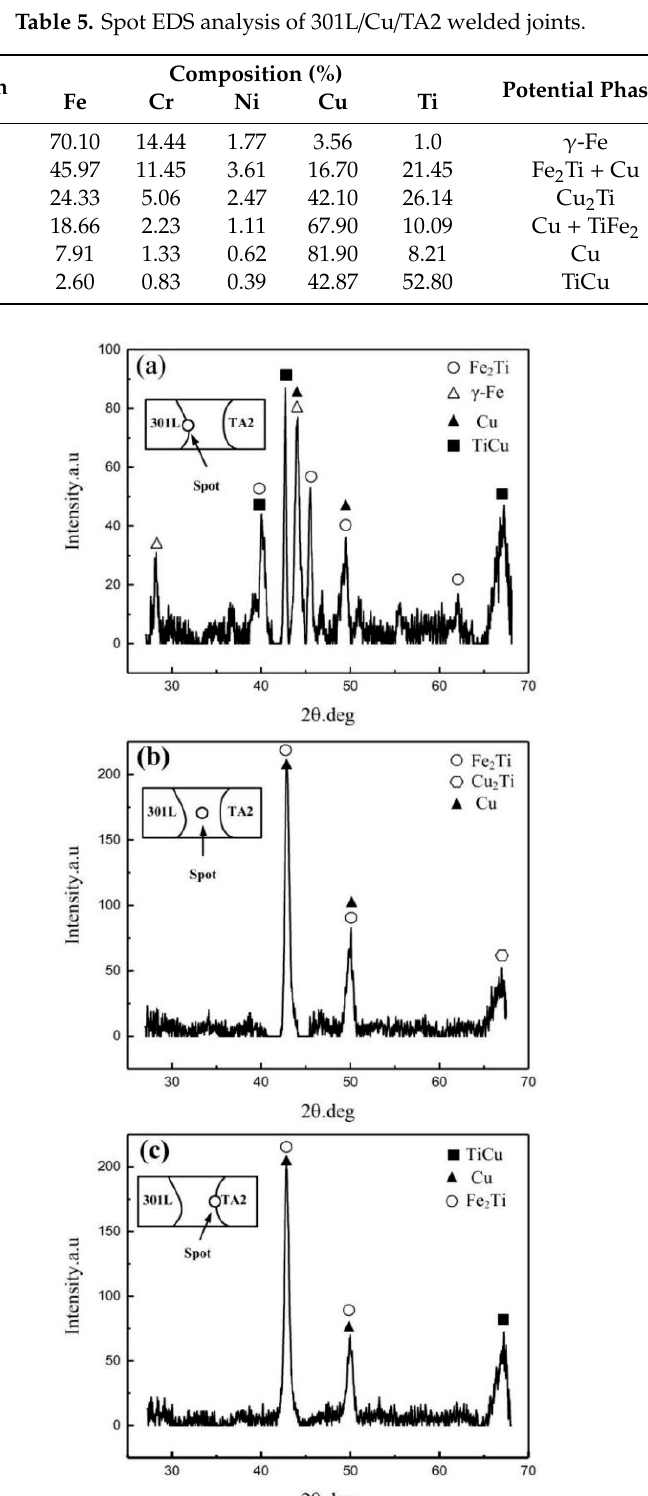
Figure 15. Micro-XRD analysis results of 301L/Cu/TA2 welded joints: ( a ) 301L side; ( b ) welding center; ( c ) TA2 side. ( c ) TA2